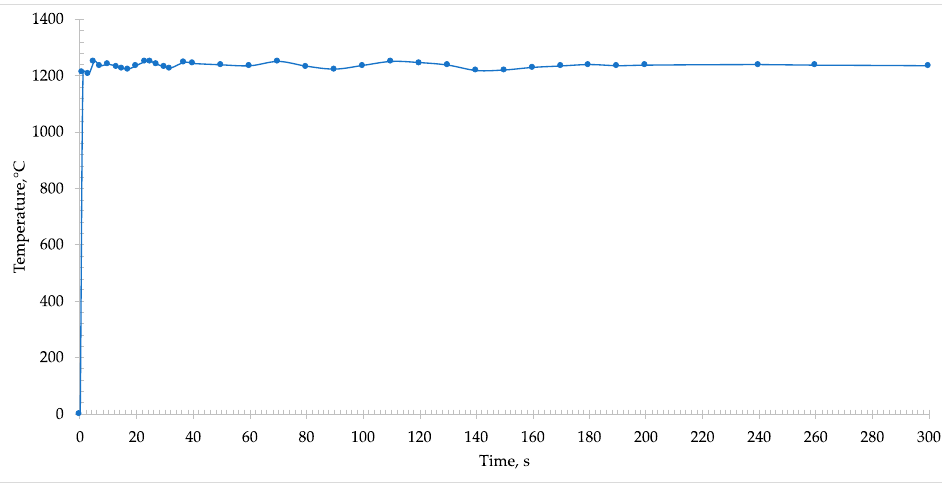
Figure 5. Heating rates of 1st MW roasting process at 0.6 kW, 1 L/min N 2 flow constant and 300 s.